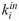
Network of citations.The network includes 9,423 articles that received or made at least one citation. The visualization of the network was obtained through the network visualization software Gephi® (Gephi® Consortium, Compiegne, France). The size of each node i is proportional to its in-degree kiin (i.e., the number of citations received), and the color associated with each node denotes the surgical specialty it belongs to. The network is partitioned into topological communities that are coextensive with surgical specialties (S1 Online Supplement).